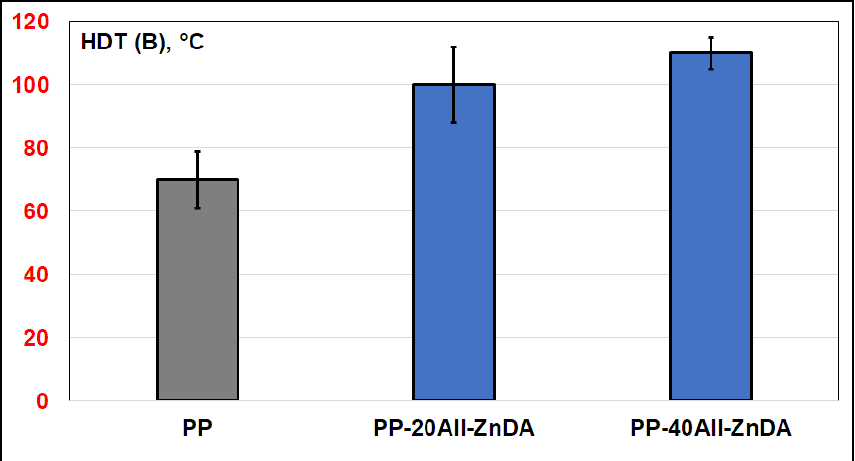
Figure 14. Evaluation of heat deflection temperature (HDT- method B, 0.45 MPa) of PP and PP – AII Figure 13. ( a , b ) DMA evaluations of PP vs. PP – AII – ZnDA composites obtained by REx. Evolution composites produced by REx. of ( a ) s torage modulus (E’) and of ( b ) loss modulus (E “ ).